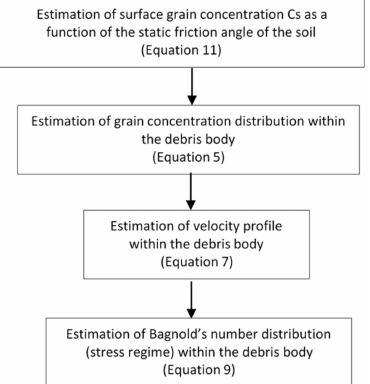
Figure 14. Flow chart of the procedure by using the proposed modified